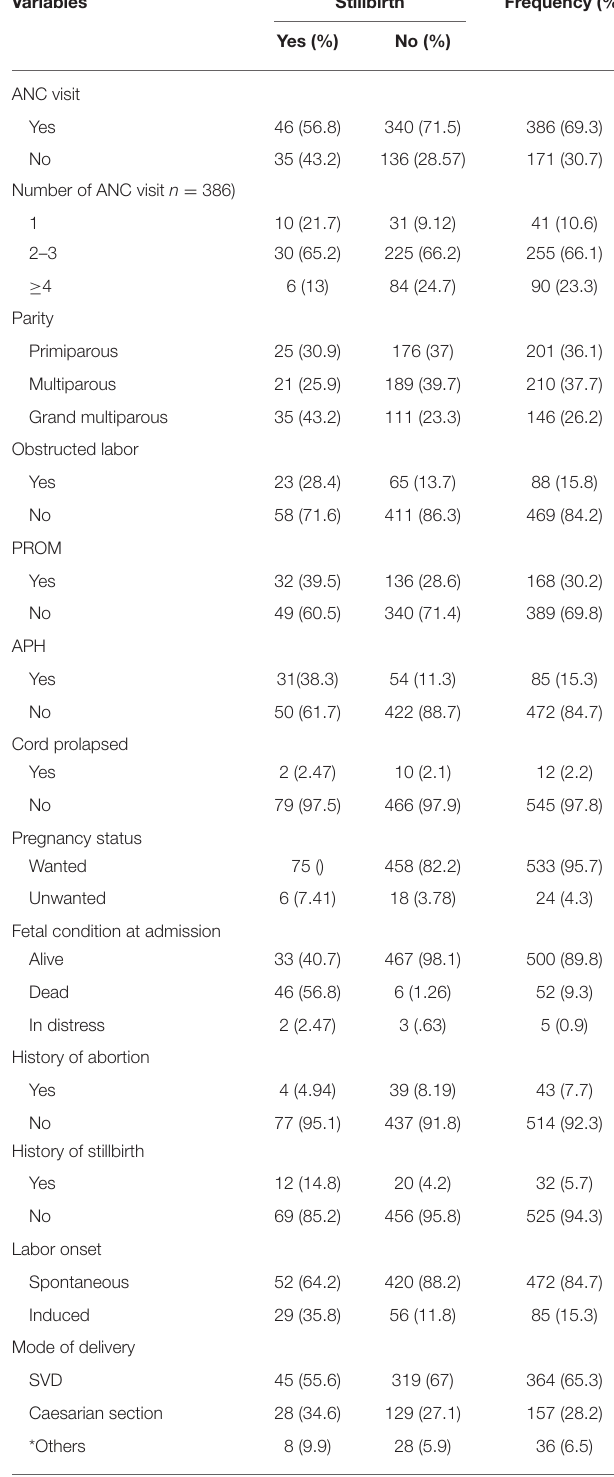
TABLE 2 | Obstetrics condition of study participants ( n = 557), Hiwot Fana Specialized University Hospital, Harar, Eastern Ethiopia, 2018/2019.